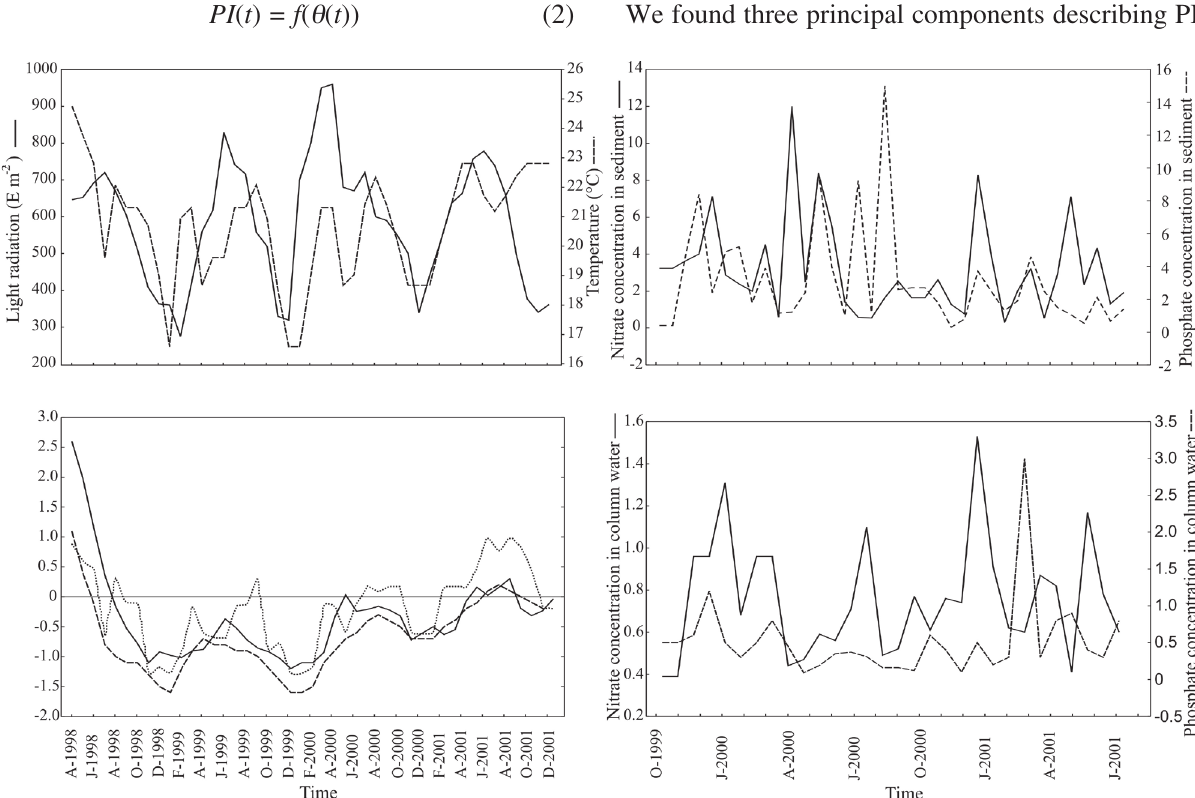
Fig . 1. – measured environmental variables. a) light radiation and temperature. b) Phosphate and nitrate concentrations in sediment. c) the continuous line represents the time series of mEi values. Small dashed line symbolises the oni values. Sea surface anomalies values are represented in large dashed line. d) Phosphate and nitrate concentrations in sediment in column